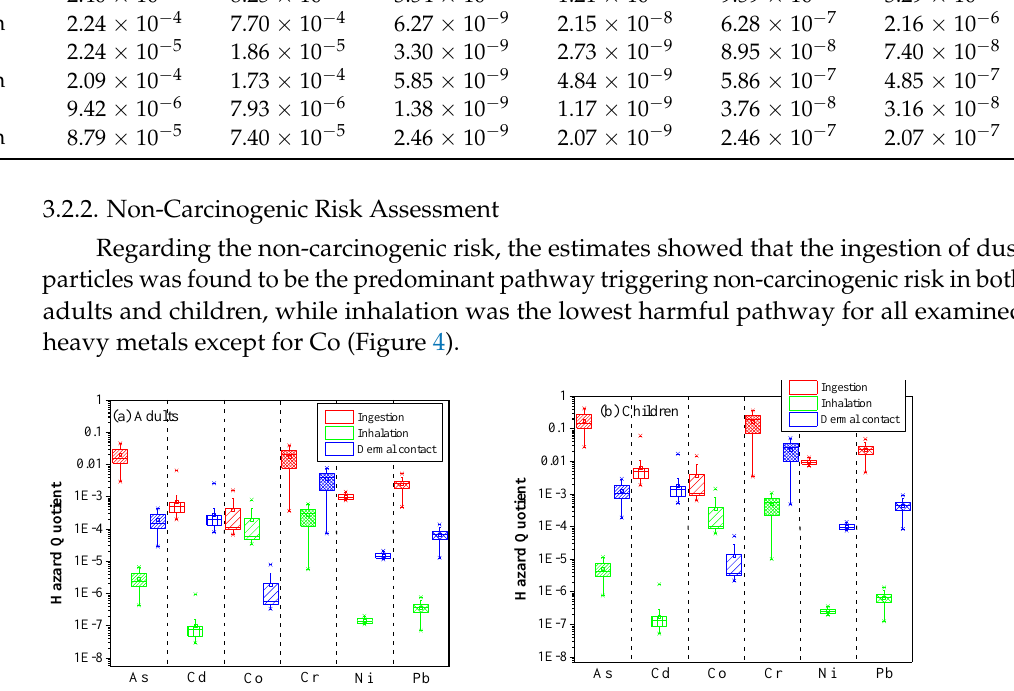
Figure 4. Hazard Quotient (HQ) values for non-carcinogenic health risk of selected heavy metals in household dust in Asaluyeh for adults ( a ) and children ( b ), and for the three pathways (ingestion, inhalation and dermal contact).